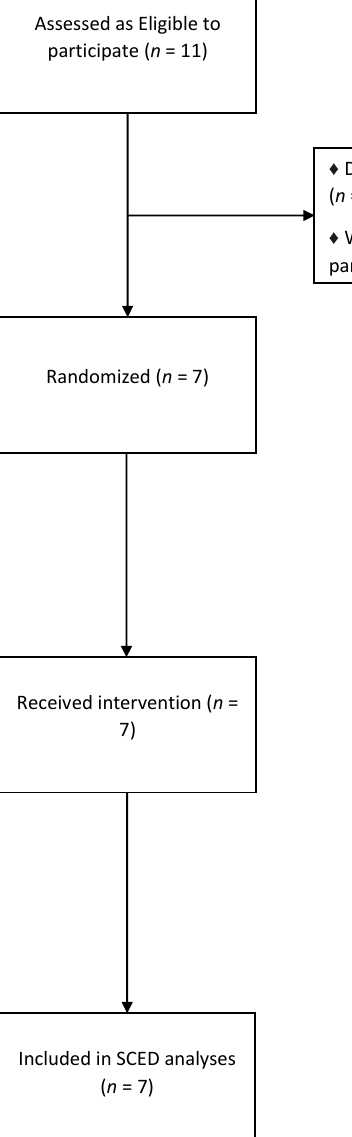
Figure A1. Study 1 participant flowchart.